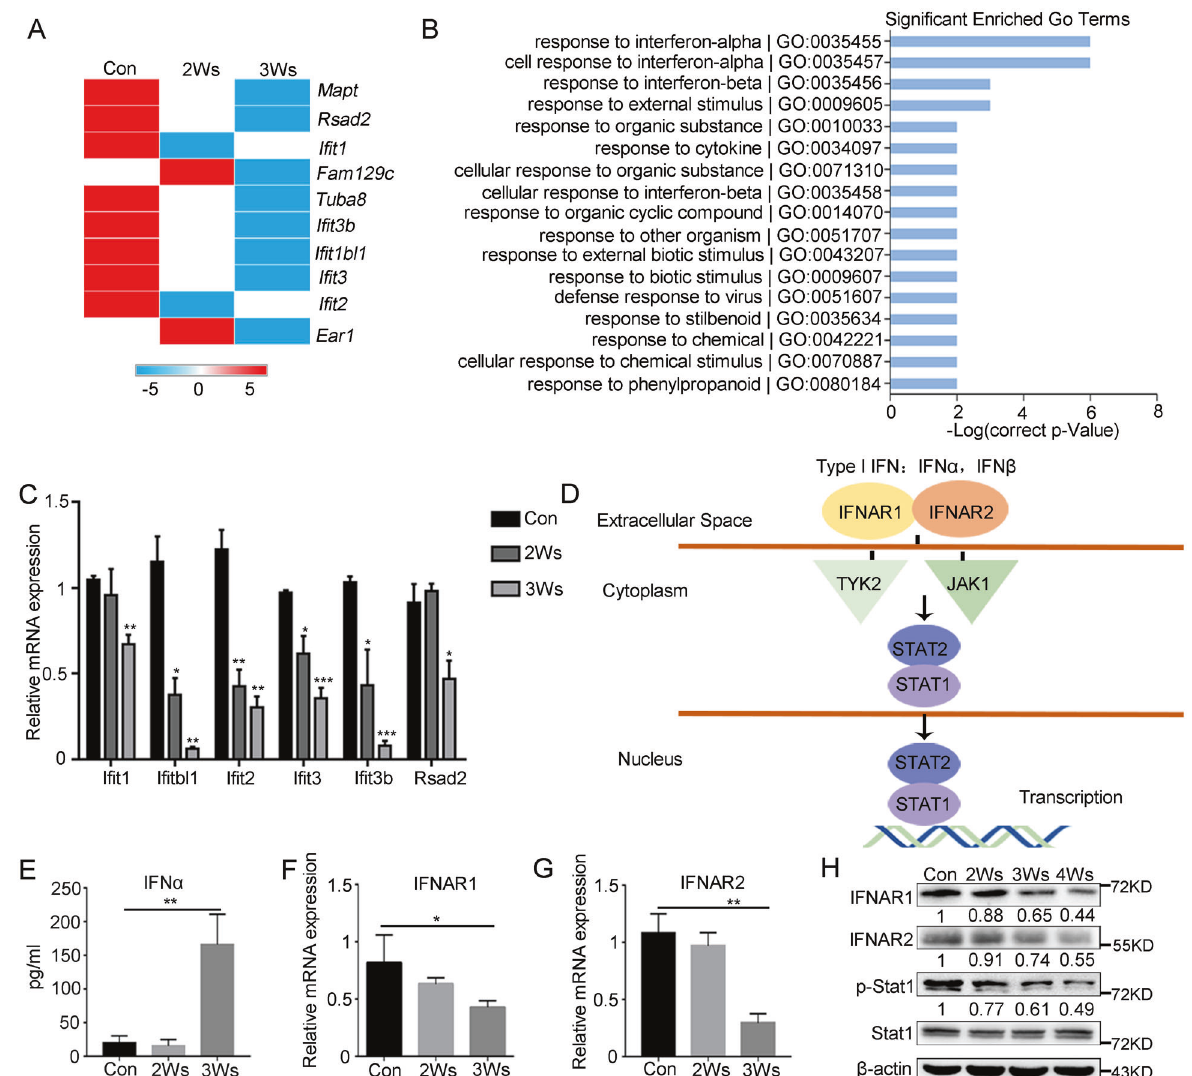
kilobase of transcript per million (FPKM) values. B Gene ontology (GO) enrichment analysis of G-MDSCs in peripheral blood taken from mice after different durations of tumor bearing based on differentially expressed genes (FC > 2). C Technical validation of the array data by Q-PCR ( n = 4). D Schematic diagram of the IFN-I pathway. E The content of IFN α in serum taken from mice after different durations of tumor bearing was analyzed by ELISA ( n = 4). F , G The expression of IFNAR1 and IFNAR2 in G-MDSCs in peripheral blood taken from mice after different durations of tumor bearing was analyzed by Q-PCR ( n = 4). H The expression of IFNAR1, IFNAR2, Stat1 and p-Stat1 in G-MDSCs in peripheral blood taken from mice after different durations of tumor bearing was analyzed by western blot. Results are mean ± SD. Unpaired t- test was used to determine signi fi cance (* p < 0.05, ** p < 0.01 and *** p <